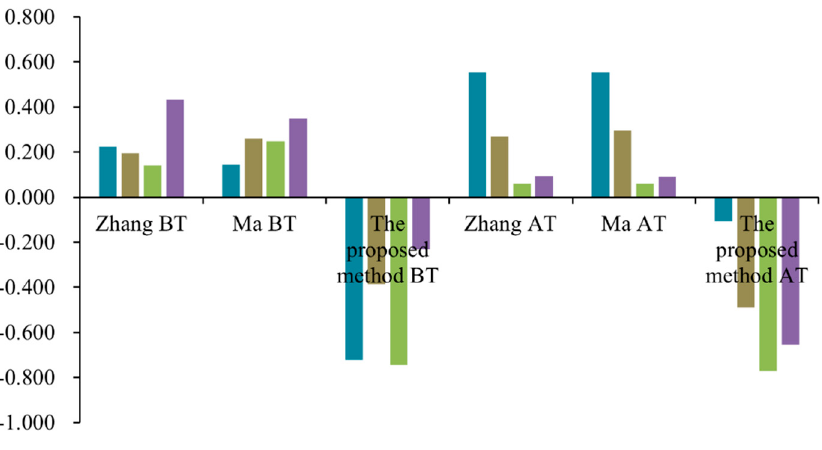
Figure 16. Comparison of fusion results using the three methods.